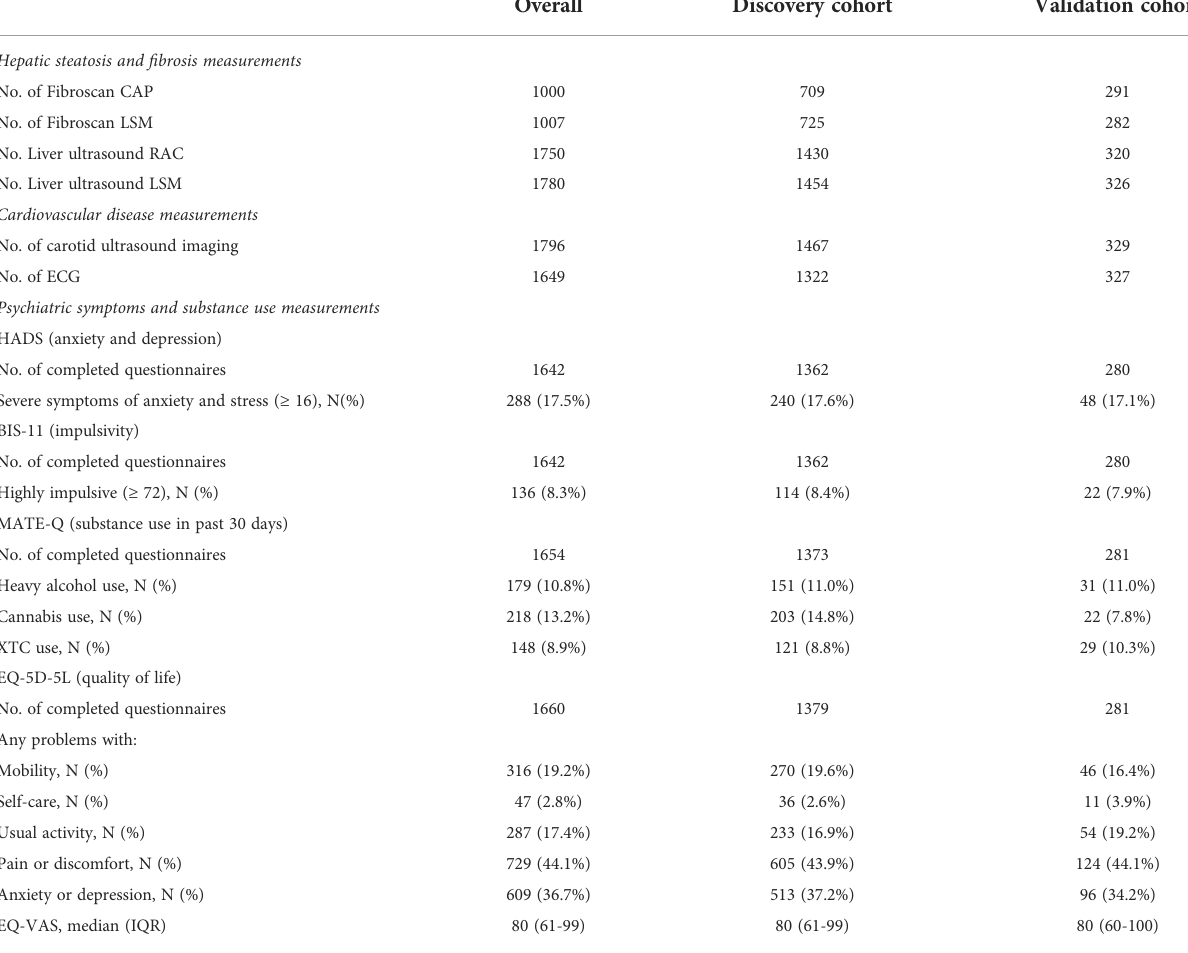
TABLE 4 Liver, vascular and psychiatric measurements at baseline